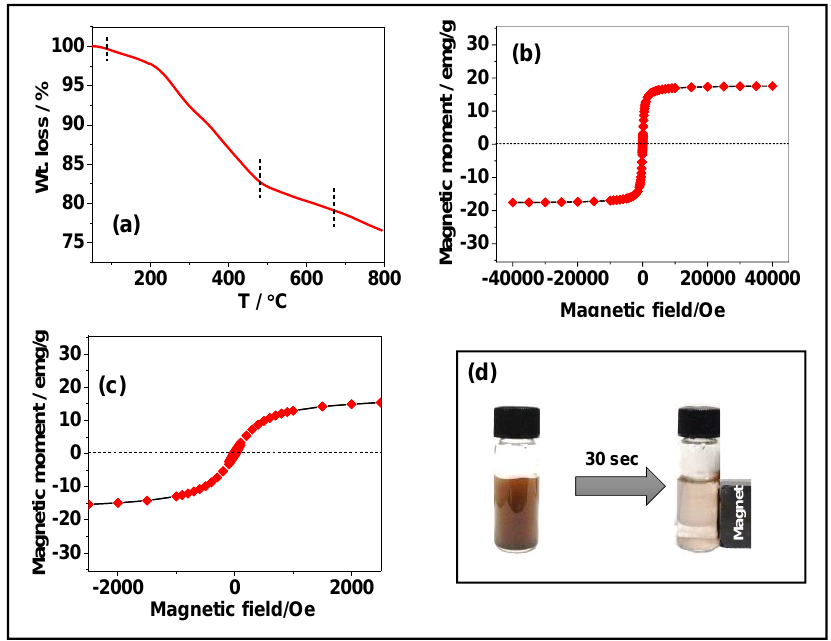
Figure 3. ( a ) TGA curve; ( b , c ) magnetization curve of FeNP@MSHC NPs. ( d ) The photographic image shows the attraction of FeNP@MSHC NPs by external magnetic field.